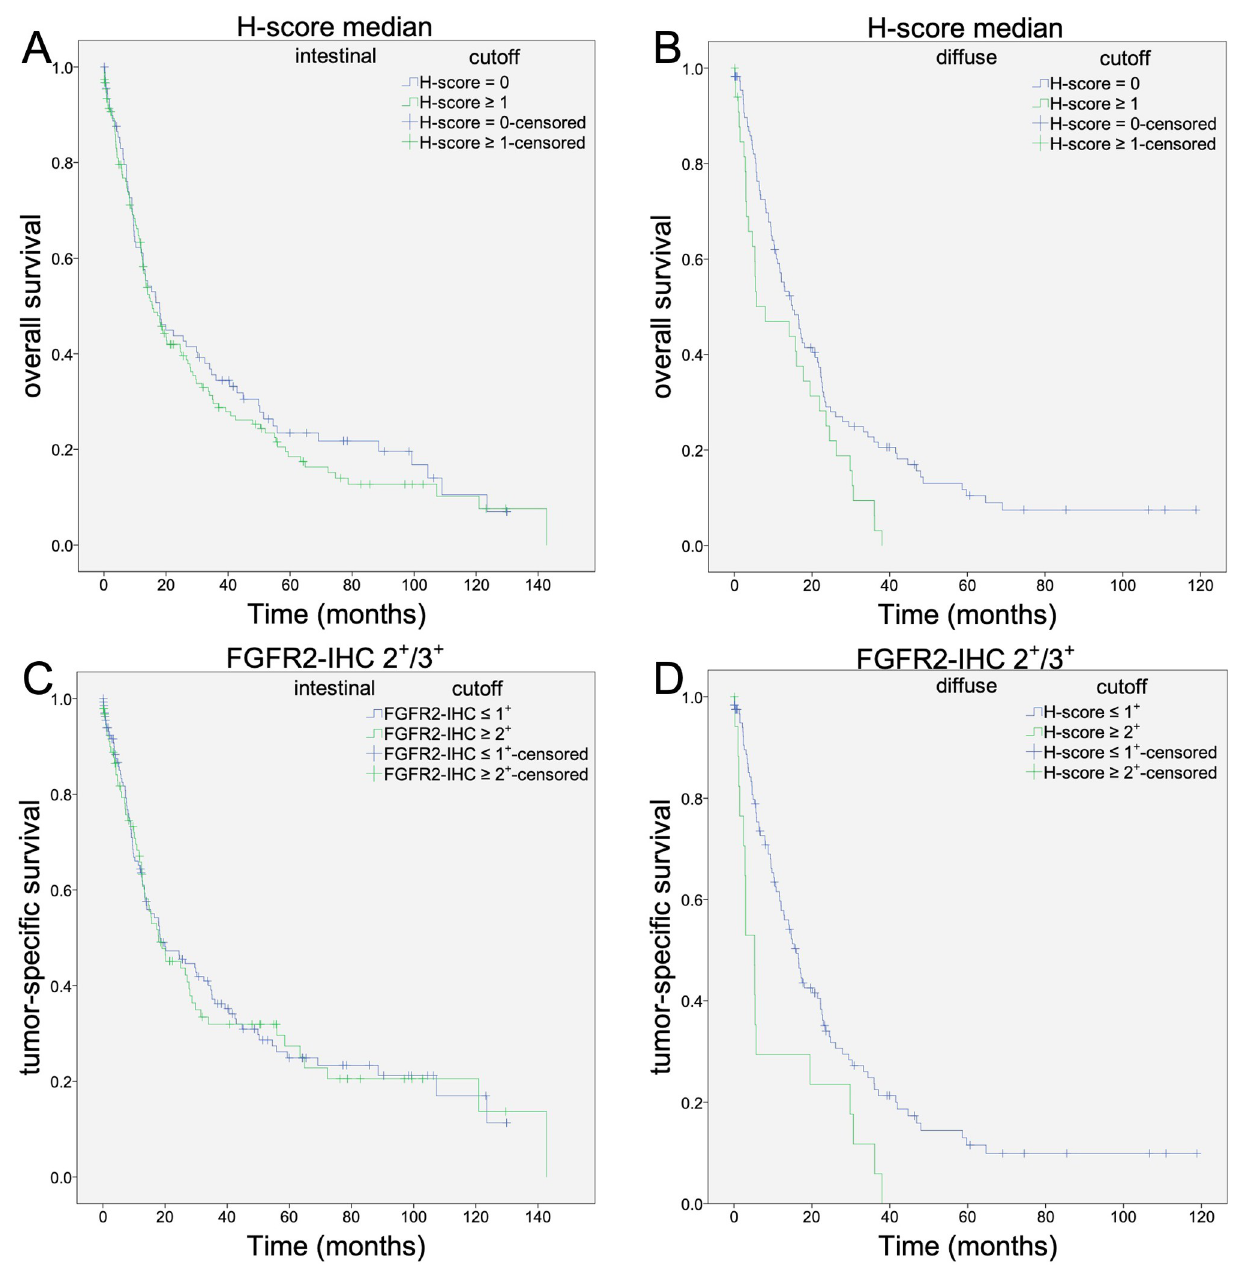
Fig 4. Analysis of patient overall- and tumor-specific survival using different definitions of FGFR2 positivity according to Laure´n classification. Further analysis of survival time was performed separately according to the subgroups of the Laure´n classification. Initially, the median Hscore was also used as a cutoff (A-B). For the intestinal type (A), there was no difference. For the diffuse-type (B), significantly worse overall and tumor specific survival was seen for patients with increased FGFR2 expression. The same trend was seen when using the presence of FGFR2-IHC 2+ or 3+ (C-D) as a cutoff. Here, also in patients with intestinal-type carcinoma (C), there was no difference in overall or tumor-specific patient survival. In patients with diffuse- type gastric carcinoma (D) and increased FGFR2 expression, significantly worse overall and tumor-specific survival was